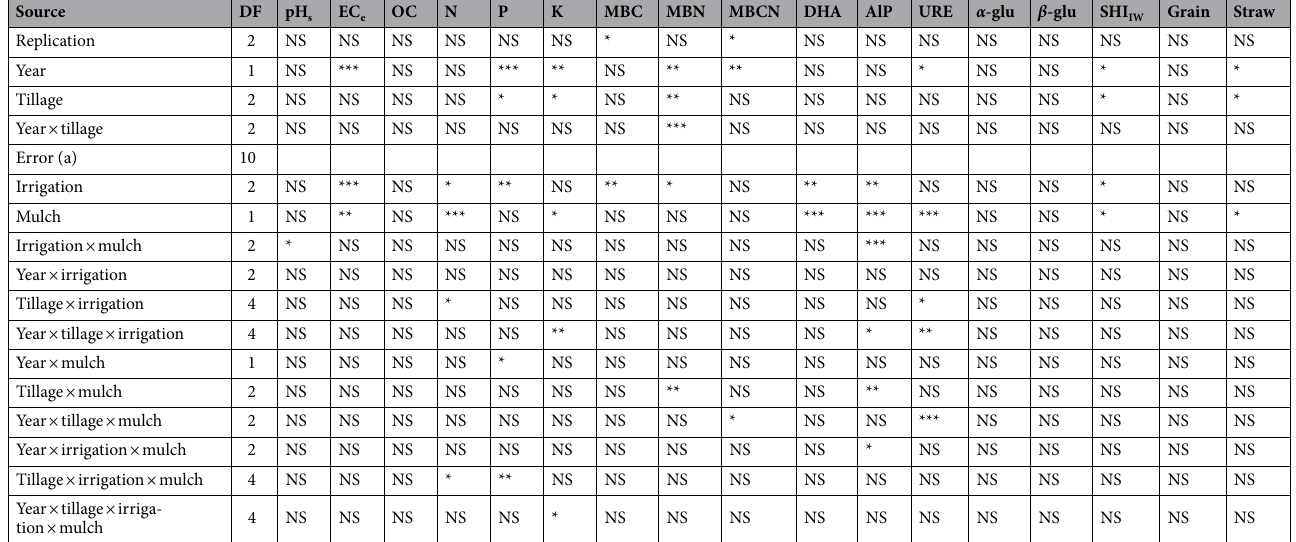
Table 3. Analysis of variance of tillage, mulch and saline irrigation on pH s , EC e , Walkley and Black oxidizable organic C (WBOC) and KMnO 4 oxidizable N, Olsen’s P and NH 4 OAc extractable K, soil microbial biomass carbon and nitrogen (MBC and MBN), microbial biomass carbon nitrogen ratio (MBCN), dehydrogenase (DHA), alkaline phosphatase (AlK), urease (Ur), α - and β -glucosidase ( α -/ β glu), wheat grain and straw yield and weighted linear soil health index (SHI IW ); * P < 0.05, ** P < 0.01, *** P < 0.001 and NS: not significant ( P >